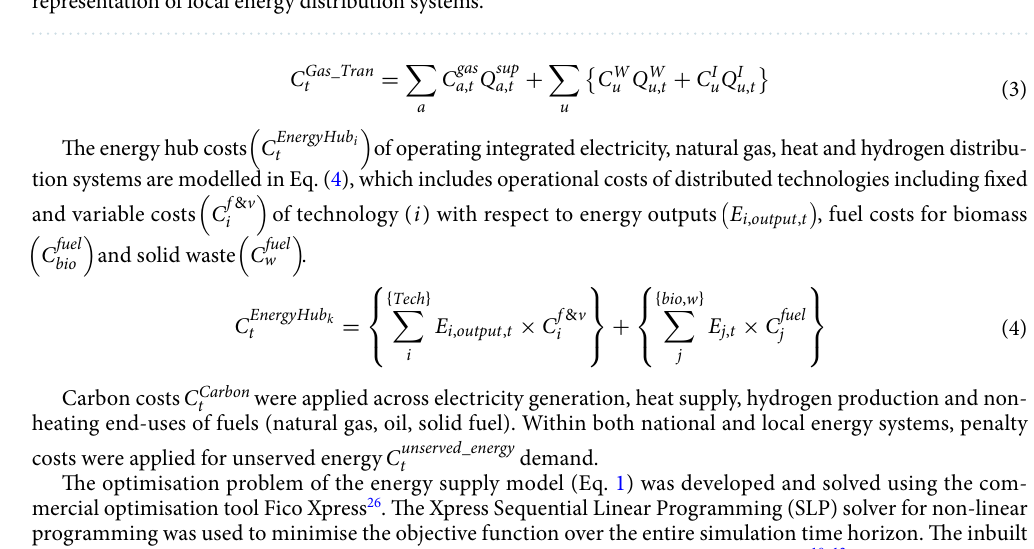
Figure 1. Integrated energy simulation framework linking an energy supply, energy demand, and a transport model. A stylised representation of the energy supply system model is shown, including the energy hub representation of local energy distribution